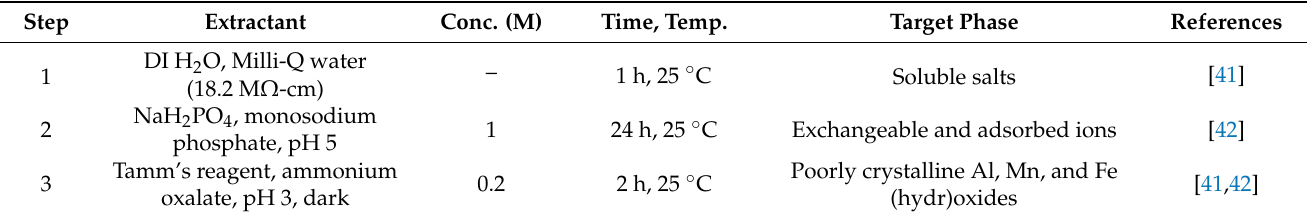
Table 1. Specific sequential extraction steps for mine tailing